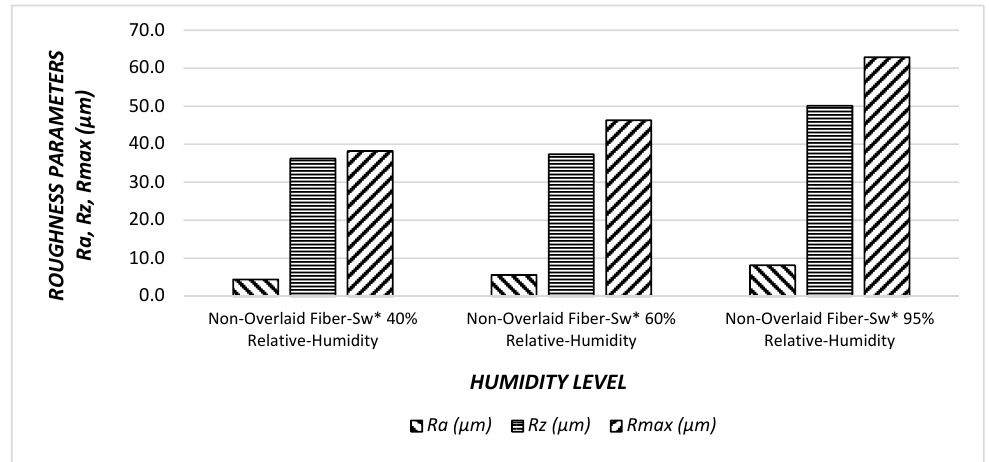
Figure 6. Surface roughness values (R a , R z , R max ) of the non-overlaid fiber sandwich panels (Fiber-Sw*) under effect of humidity.